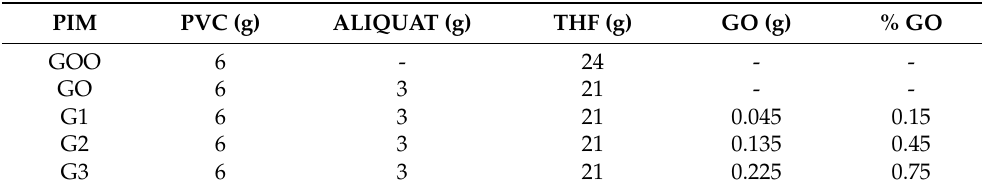
Table 1. Formulation Composition of synthesized